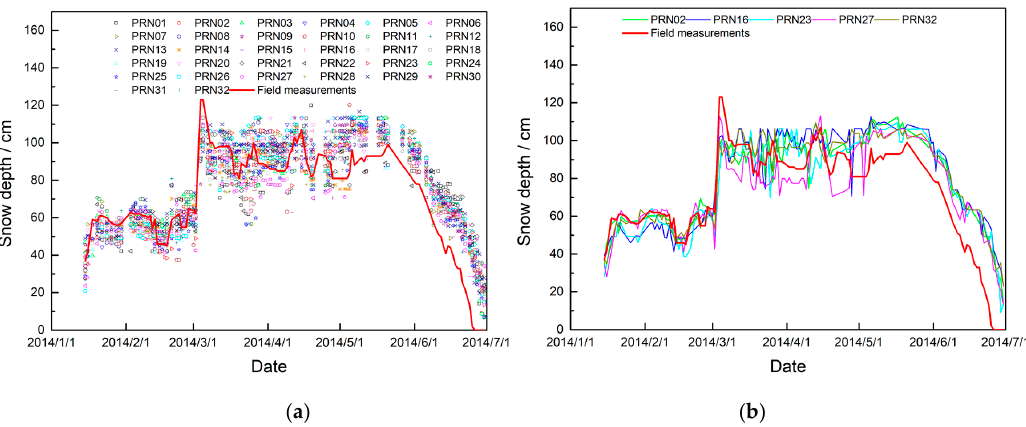
Figure 6. Scatterplot ( a ) and line plot ( b ) of individual satellite-derived snow depths versus in-situ snow depths in 2014. Red lines represent the measured snow depths from field work. Scatterplot of all individual satellites is more beneficial to show the dispersion of individual satellite-derived snow depths in one day, while line plot of selected individual satellites better highlights the trends of individual satellite-derived snow depths.